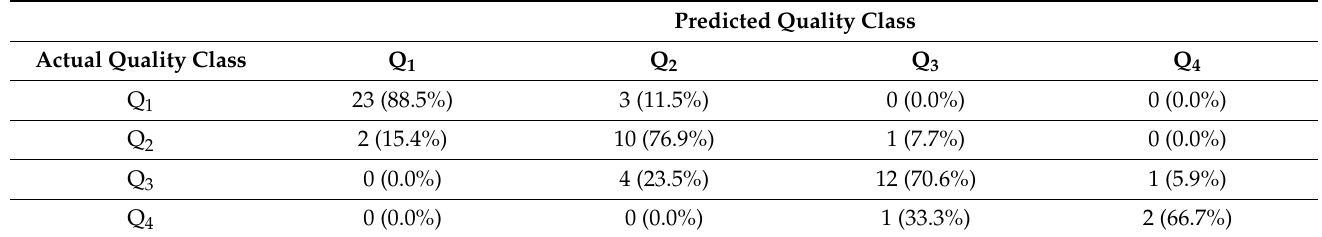
Table 6. Confusion matrix output for the logs’ quality data from the ANN model, with the numbers and percentages of classified spruce logs.